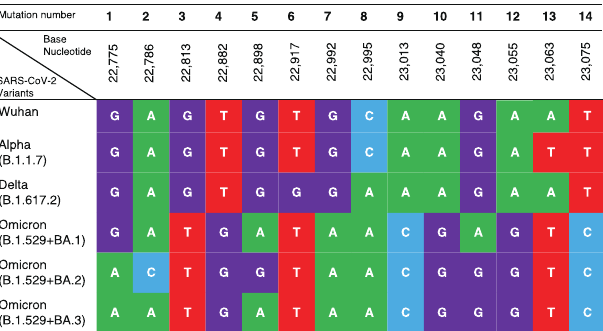
Figure 2. Classification checkpoints in the spike gene for identification of SARS-CoV-2 variants. This figure shows the unique classification checkpoints in the targeted spike gene from base nucleotides 23,735 to 23,532, which covers the part of the spike gene including the receptor-binding domain (RBD) and provides 798 base pairs for PCR. The primers for the first PCR are shown in the green triangle, and those for the second PCR are in the brown triangle. The base nucleotide changes are shown in both alignment sequences and the table box with their respective position. A: Adenine (green color), T: Thymine (red color), G: Guanine (purple color) and C: Cytosine (light blue